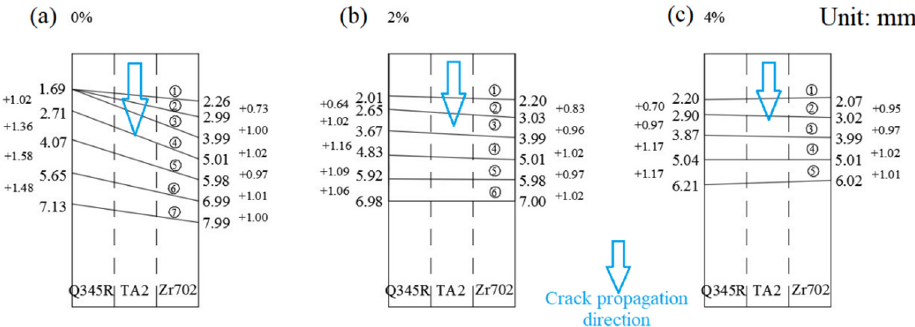
Figure 8. Front position of the through-wall crack with different pre-strain levels: ( a ) 0%, ( b ) 2%,